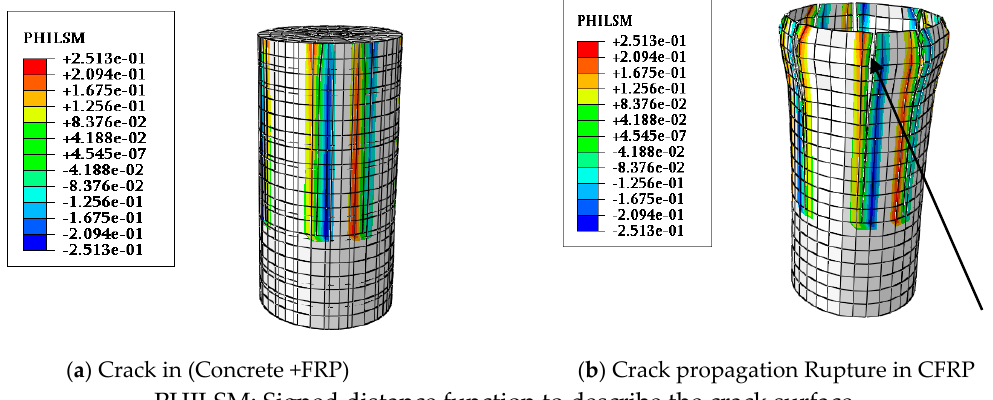
Figure 10. Crack propagation of FRP strengthened concrete column at peak load (RT).